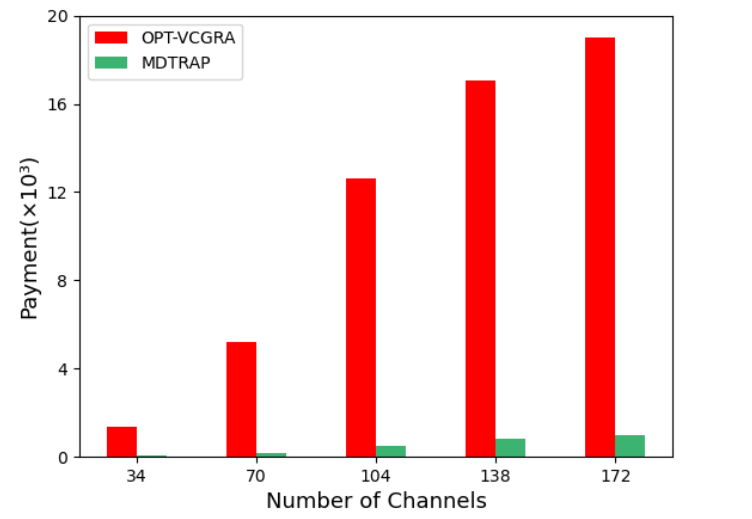
Figure 4. The total amount paid by the VSP to IoT devices under different numbers of